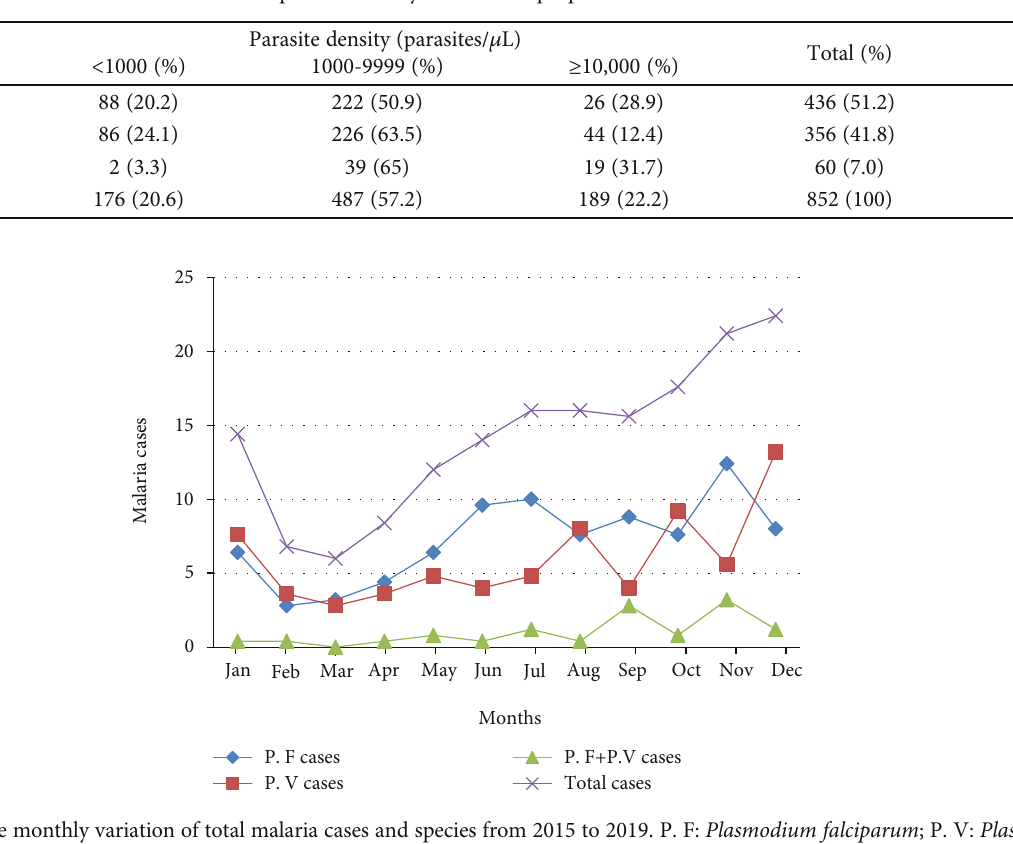
Table 2: Malaria parasite density and relative proportion from 2015 to 2019.